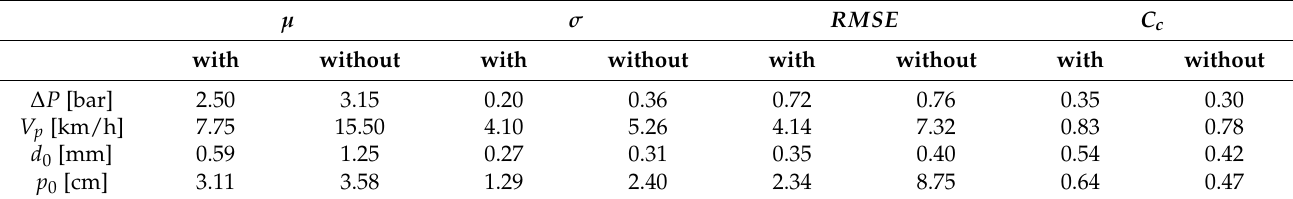
Table 6. Statistical results of OPP soft-sensor prediction with and without a interpolation